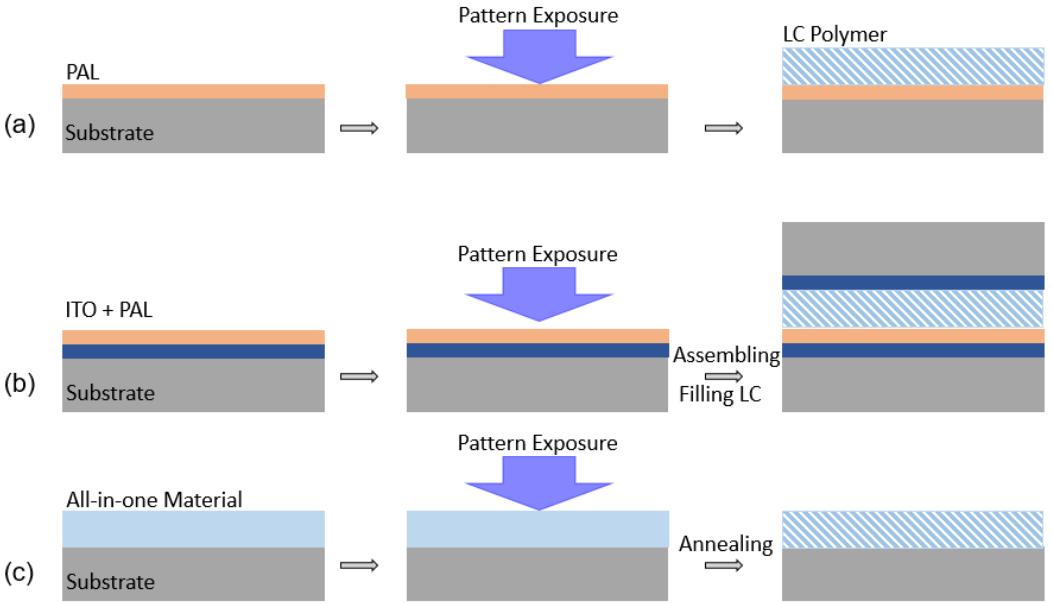
Figure 6. Fabrication procedures of PVGs. ( a ) Surface alignment for LC polymeric PVG. ( b ) Electrically responsive LC PVG. ( c ) Volume alignment.